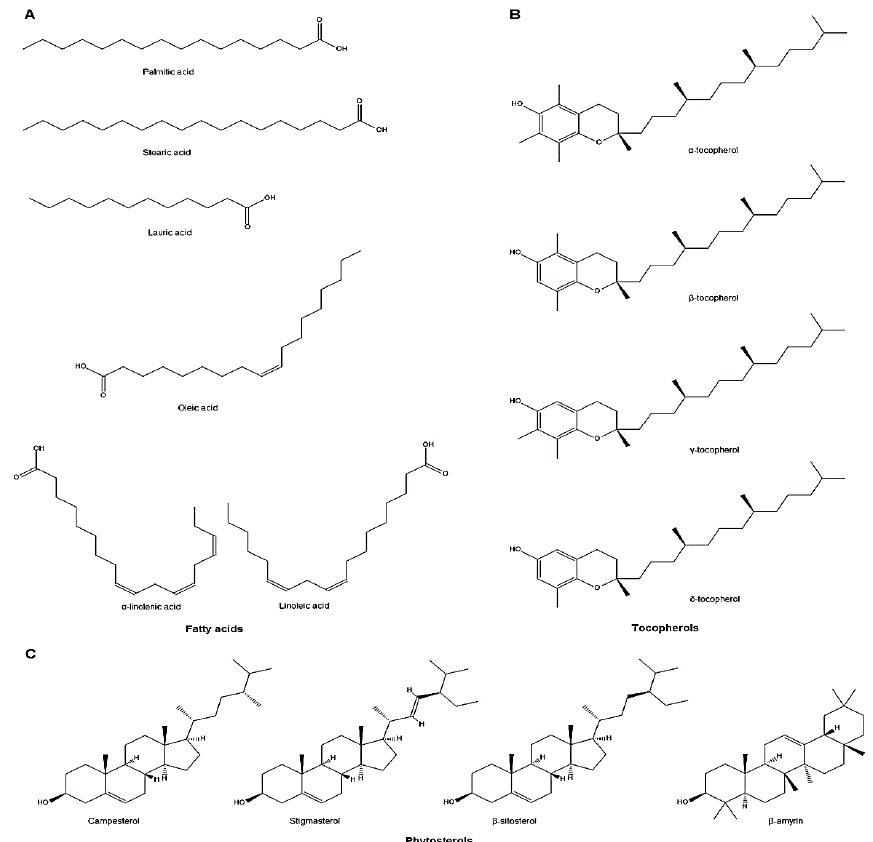
Figure 4. The chemical structures of major hydrophobic compounds identified in P. frutescens : ( A ) fatty acids; palmitic acid, stearic acid, lauric acid, oleic acid, linoleic acid, linolenic acid ( B ) tocopherols; α -tocopherol, β -tocopherol, γ -tocopherol, δ -tocopherol and ( C ) phytosterols; campesterol, stigmasterol, β -sitosterol, β